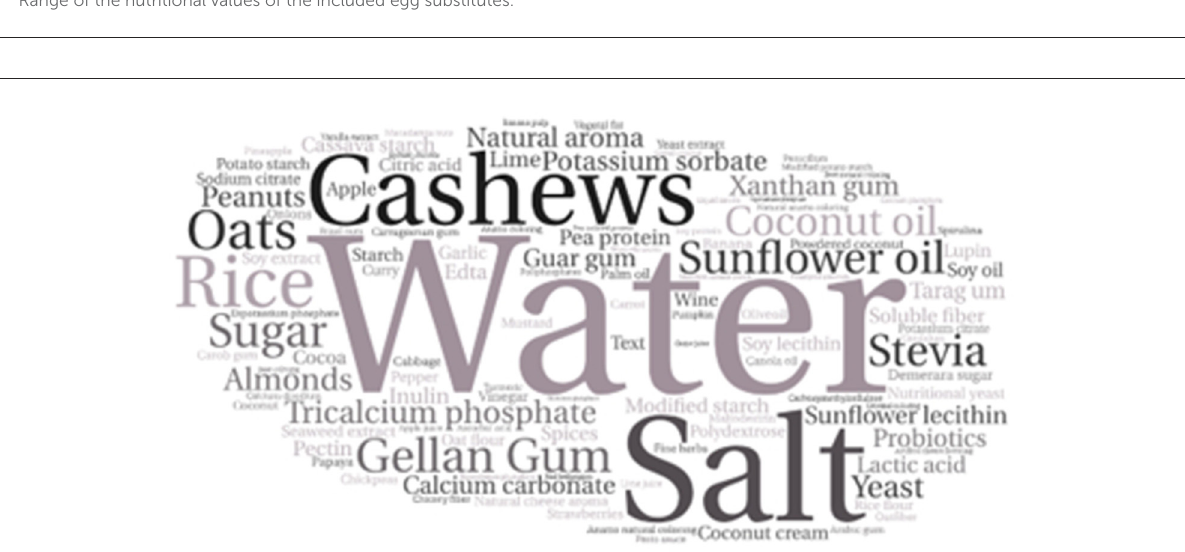
FIGURE3 Word cloud generated from the frequencies of used ingredients in beverages, yogurts, and cheese.